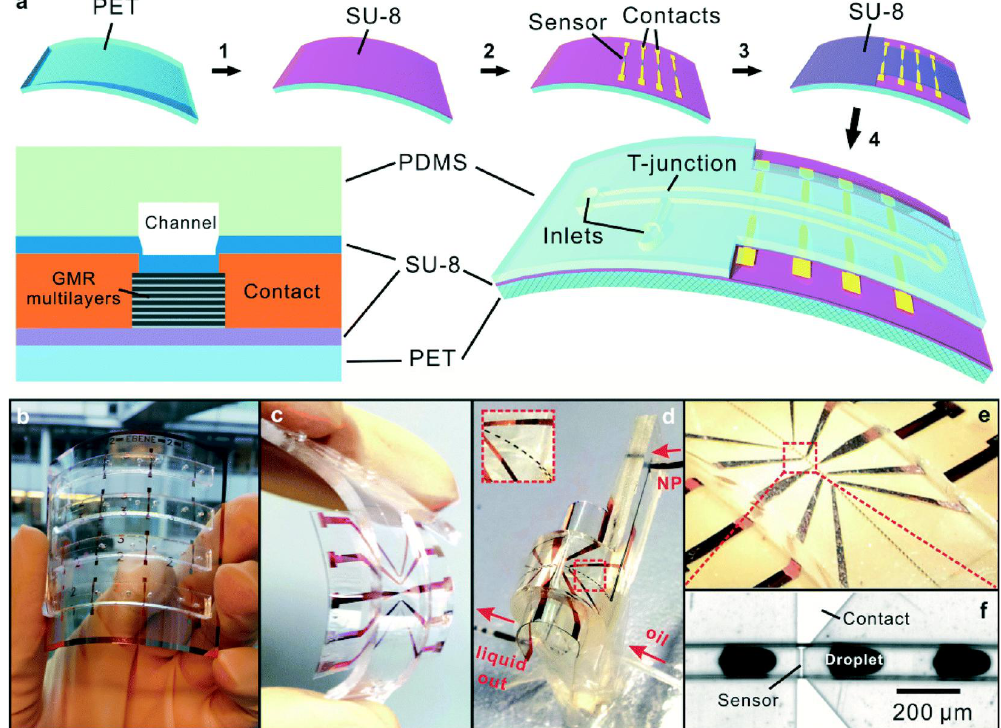
Figure 14. ( a ) Fabrication process of a flexible magnetoresistive analytic device; ( b ) electrodes integrated with microfluidic channels; ( c ) flexible analytical device; ( d ) device filled with liquid; ( e ) real time detection of emulsion droplets with magnetic nano-beads (Reprinted from [63]—Published by The Royal Society of